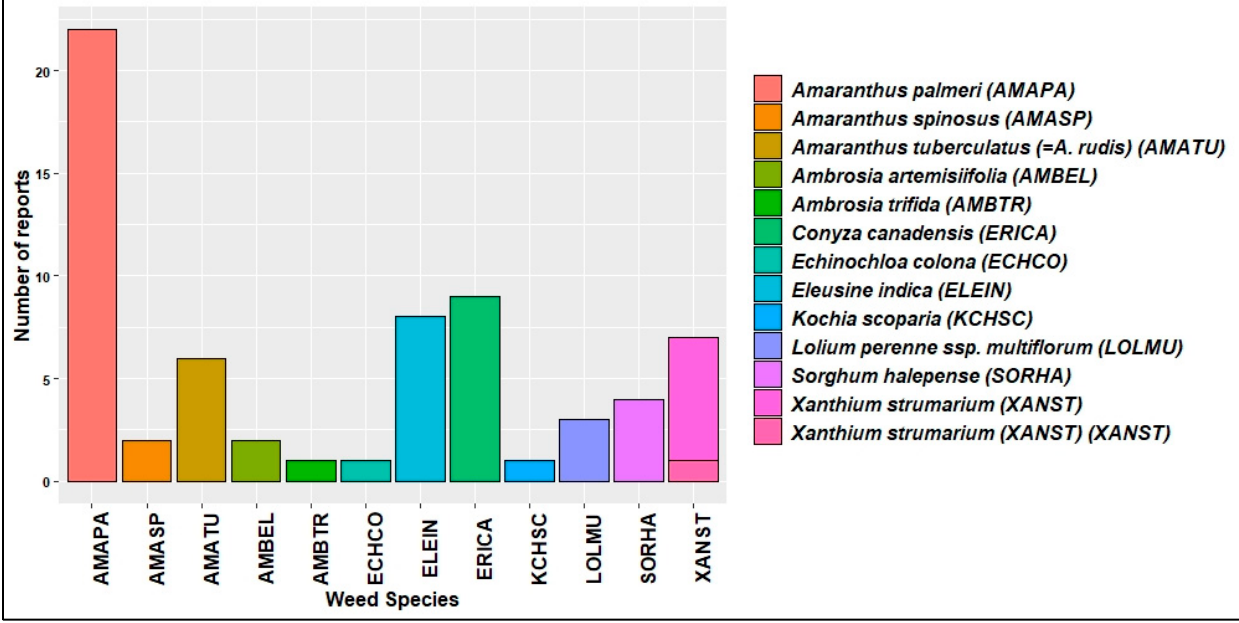
Figure 5. Weed species resistant to different MOAs in the U.S. cotton production systems [24] .